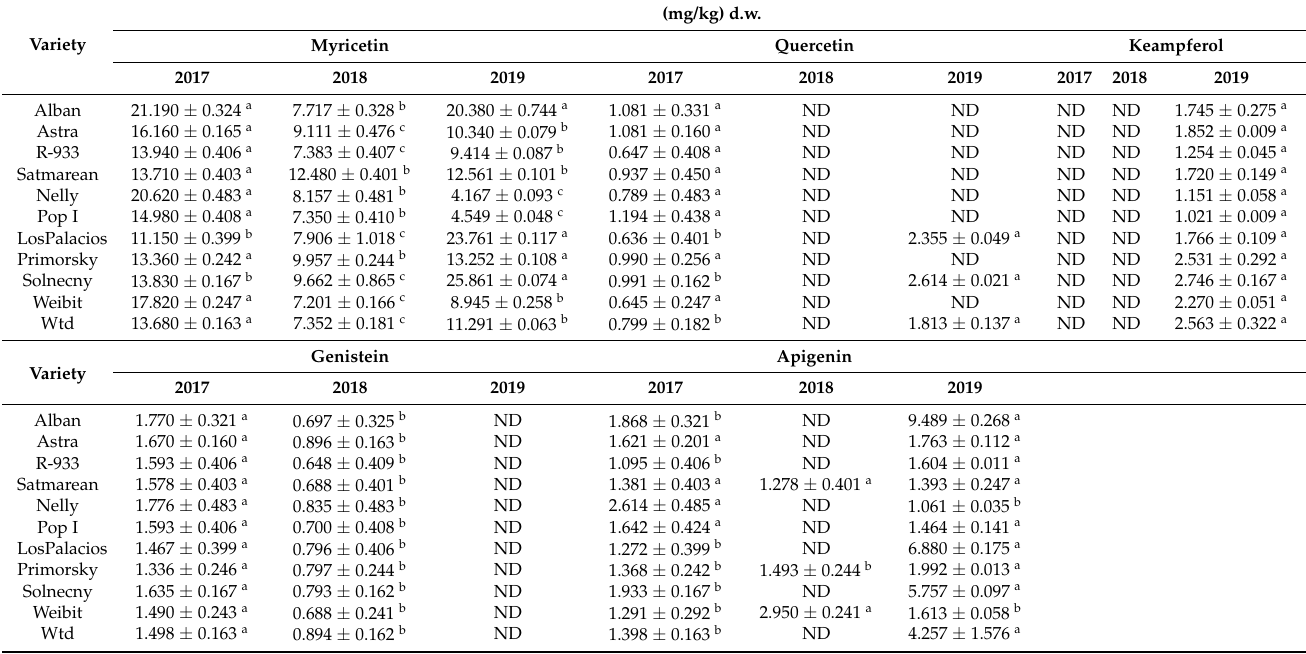
Table 5. Influence of the year of cultivation on flavonoid contents in tested varieties of lupin (mg/kg d.w., means ± standard deviations of four independent determinations). (mg/kg) d.w.